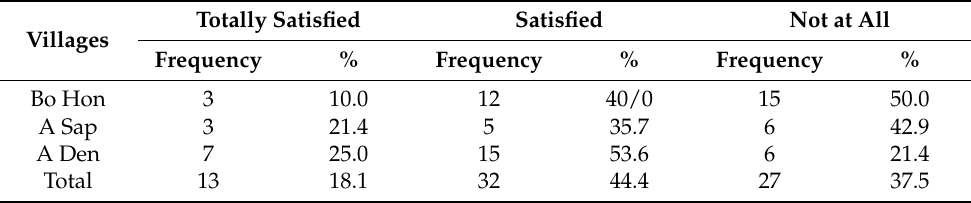
Figure 7. Crops produced proportion in the three villages. Table 2. Surveyed household satisfaction with current food production ( N =